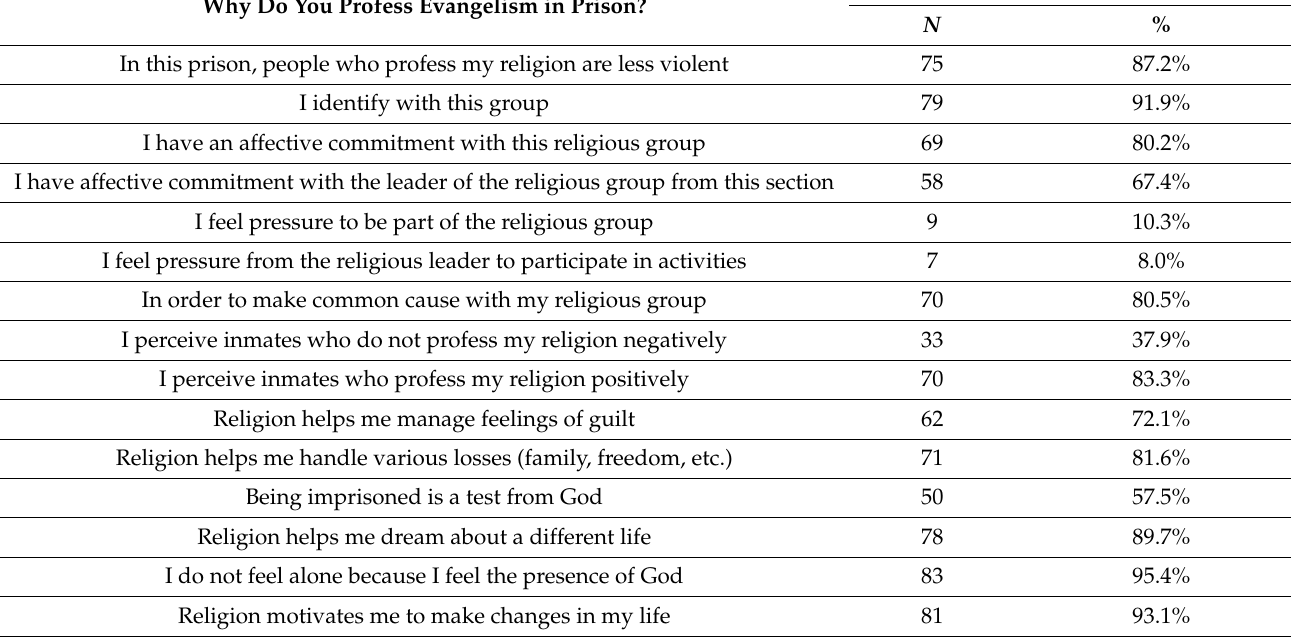
Table 2. Inmates’ motivations for professing